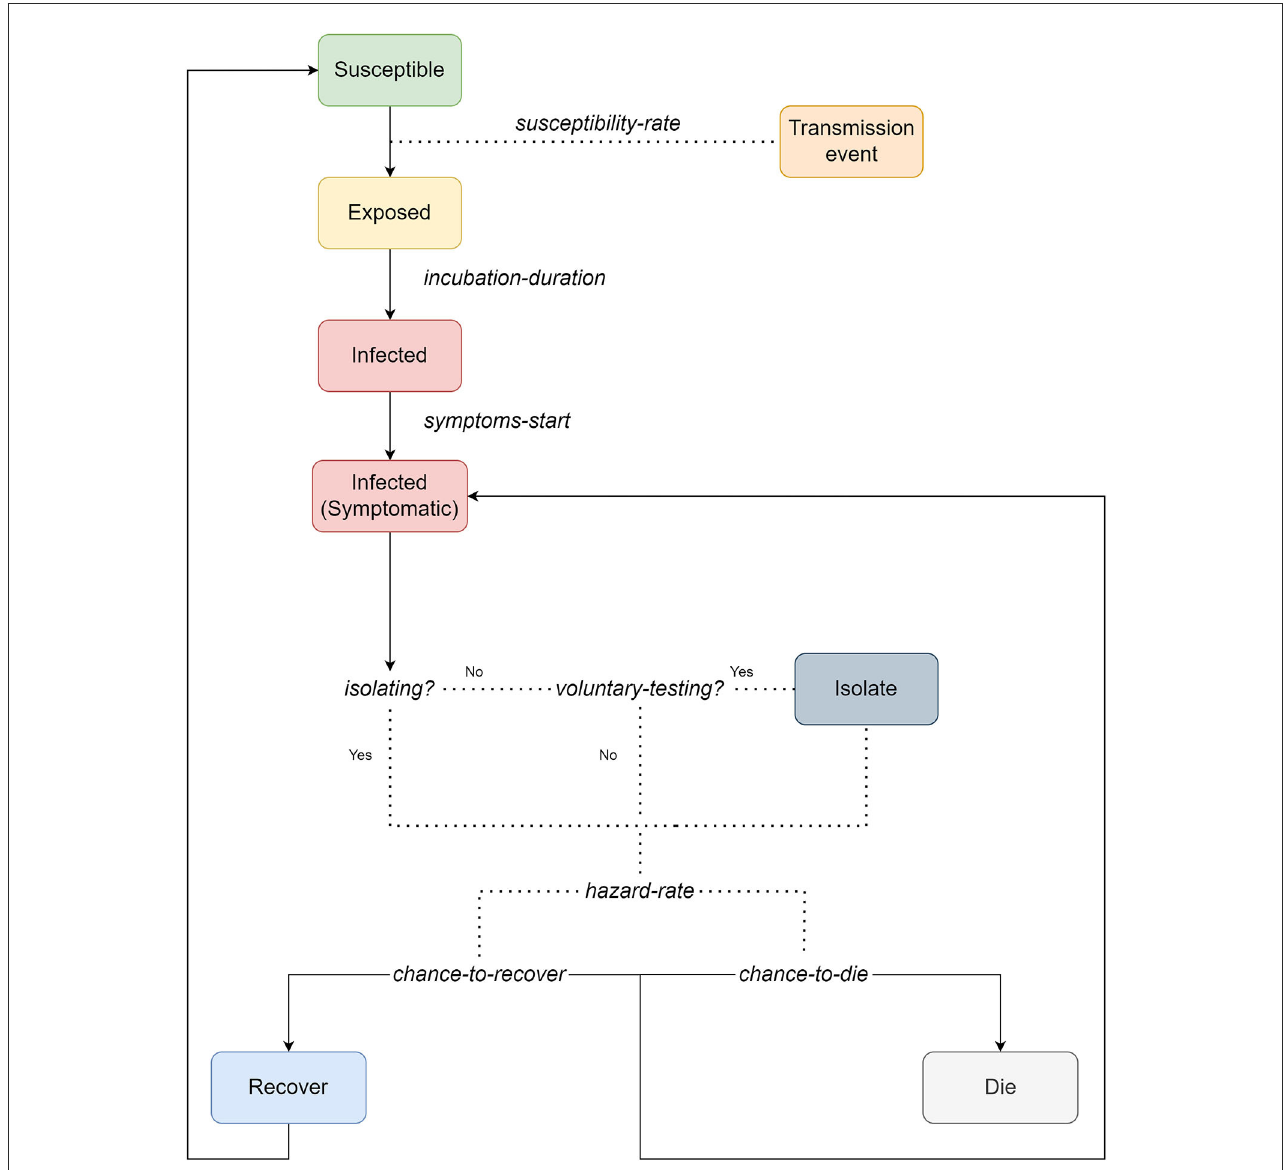
FIGURE1 Flowchart of the epidemiological dynamics with isolation based on an SEIR compartmental